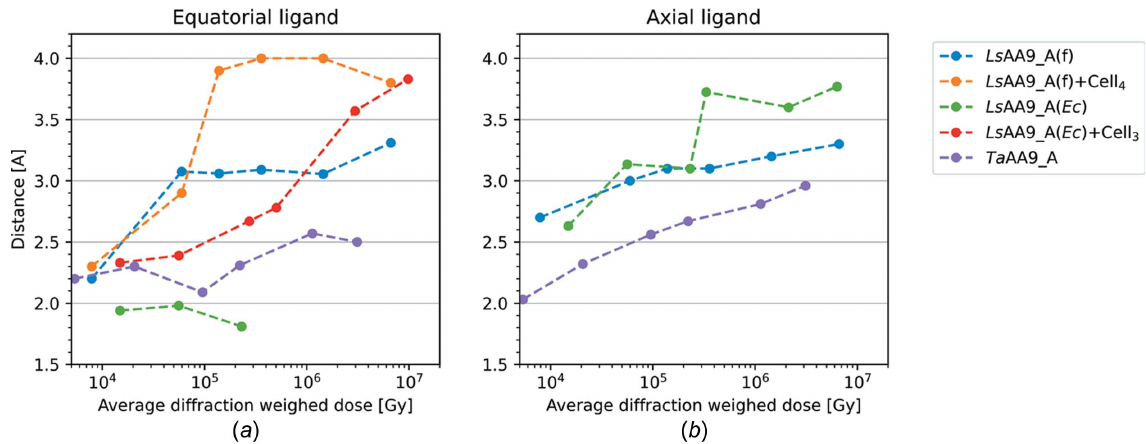
Figure 3 Measured distances as a function of the average diffraction weighted radiation dose. Distances are measured from the Cu atom to either the equatorial ligand or the axial water molecule. In substrate-binding structures, no measurement is taken for the axial water, as it has been displaced by substrate. For Ls AA9_A( Ec ), the density for the equatorial water disappears completely after the third dose structure. All distances are listed in Table Fig. S11 and Movie S3]. The equatorial water molecule sits at 2.2 A˚ from the Cu atom in the lowest-dose structure and (1.13 (cid:2) 10 6 Gy). Similar to Ls AA9_A( Ec ), the structure of Ta AA9_A has a small molecule (modelled as acrylic acid)